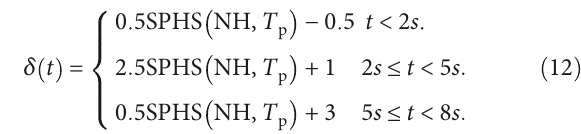
Table 1. The variation in load sti ff ness changes slowly because the Mach number does not signi fi cantly change.